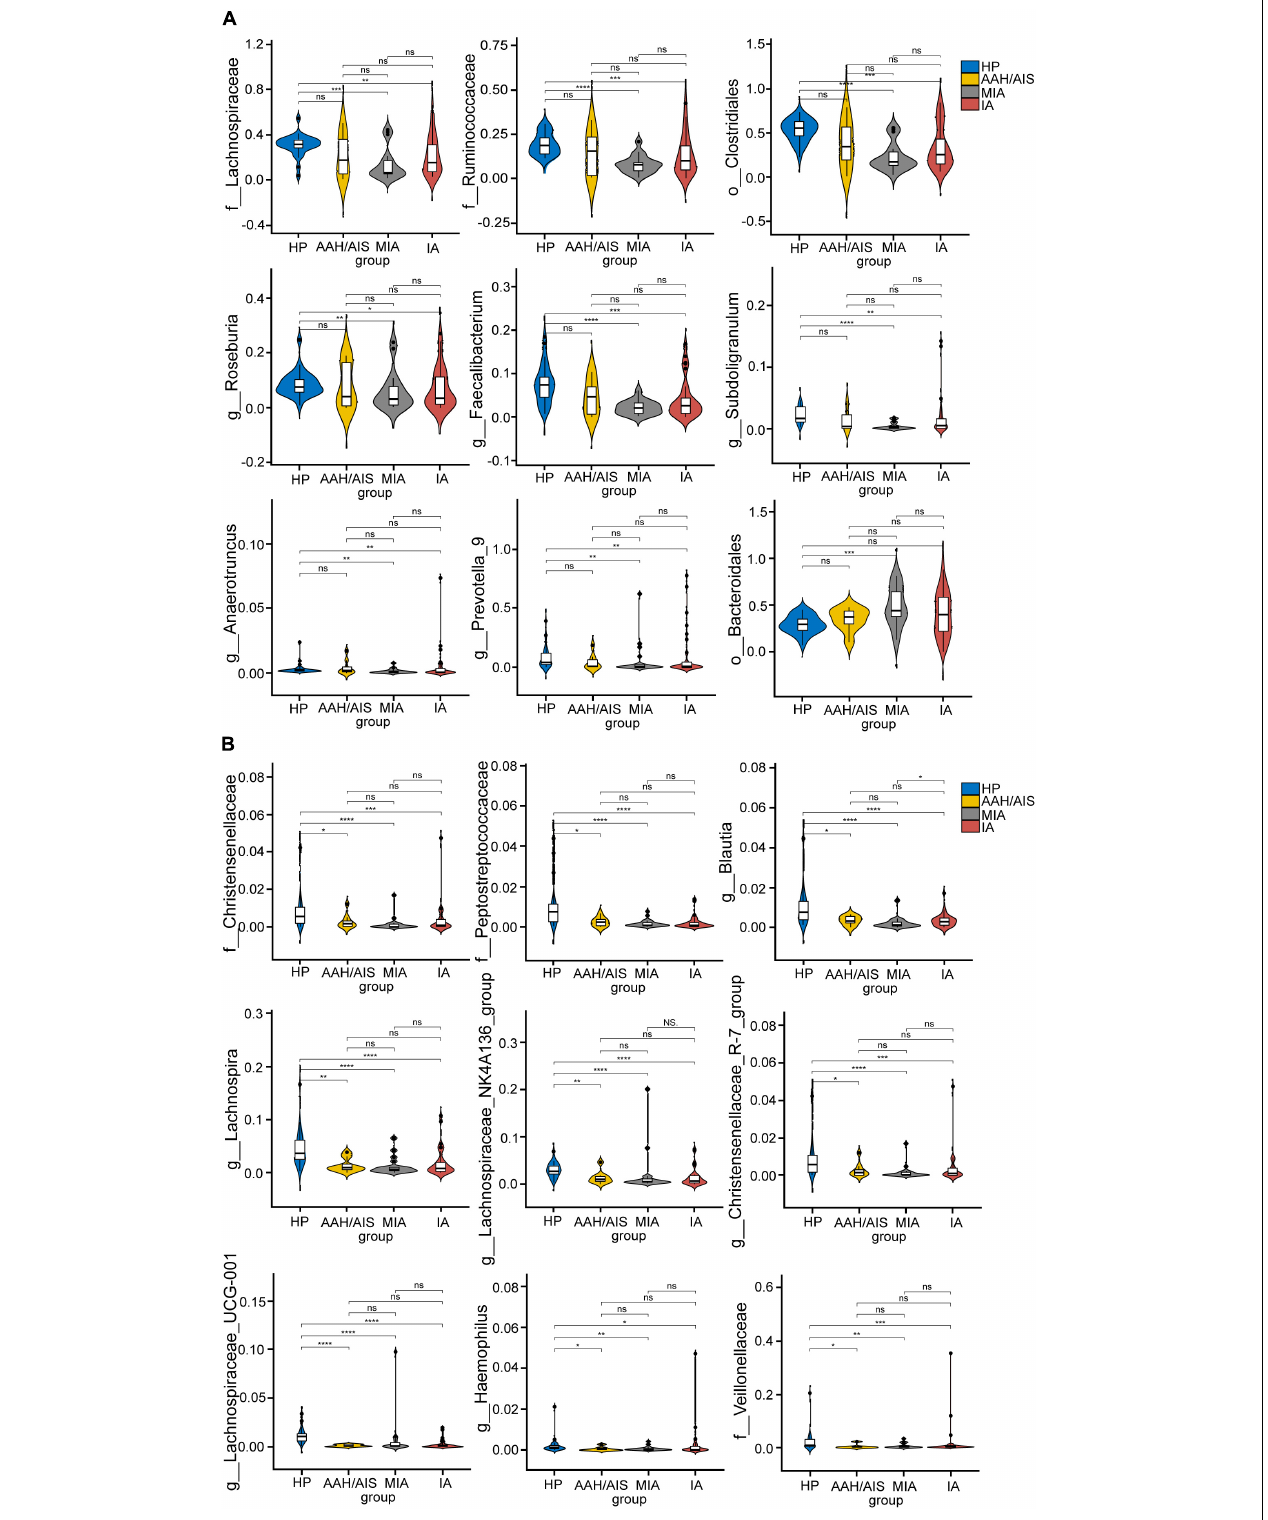
FIGURE 7 | The comparison of relative abundant microbiome between each group. (A) The Characteristic flora which are significantly HP group is significantly different from MIA, IA, and no difference. (B) The Characteristic flora which are significantly different between HP and the other three group. * P < 0.05, ** P < 0.01, *** P < 0.001, **** P < 0.0001, ns, no significance.